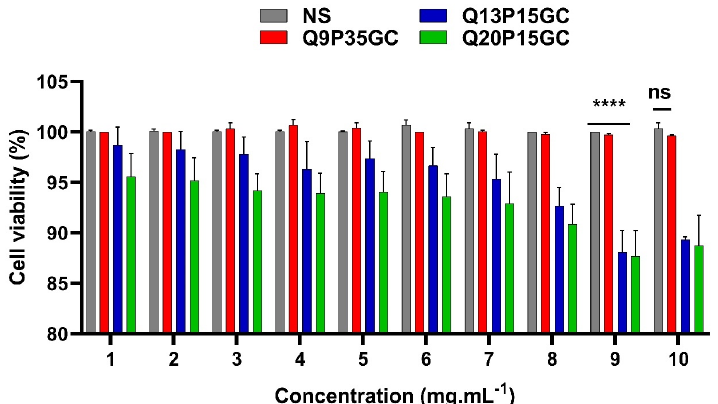
Figure 2. Alamar blue cell viability assay of GCPQ polymers against macrophage (RAW264.7). Q9P35GC showed cell viability equal to normal saline. Unpaired t -test. Abbreviations: ns, nonsignificant, NS, normal saline (0.9% NaCl), pH 7.4, ‘****’ shows statistically significant difference with p < 0.001.